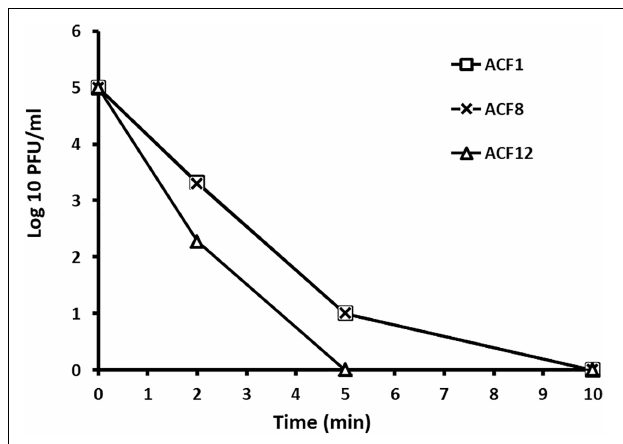
FIGURE 3 | The effect of UV light on Acidovorax phage ACF1, ACF8, and ACF12